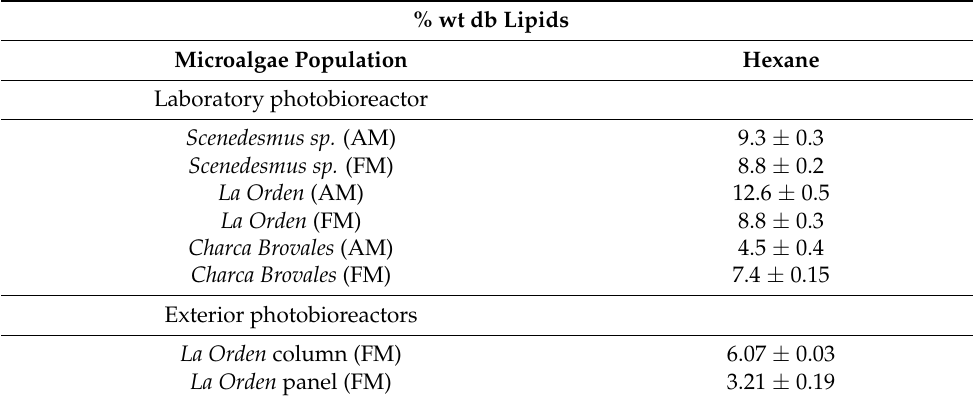
Table 4. Lipids content of the microalgae populations extracted with